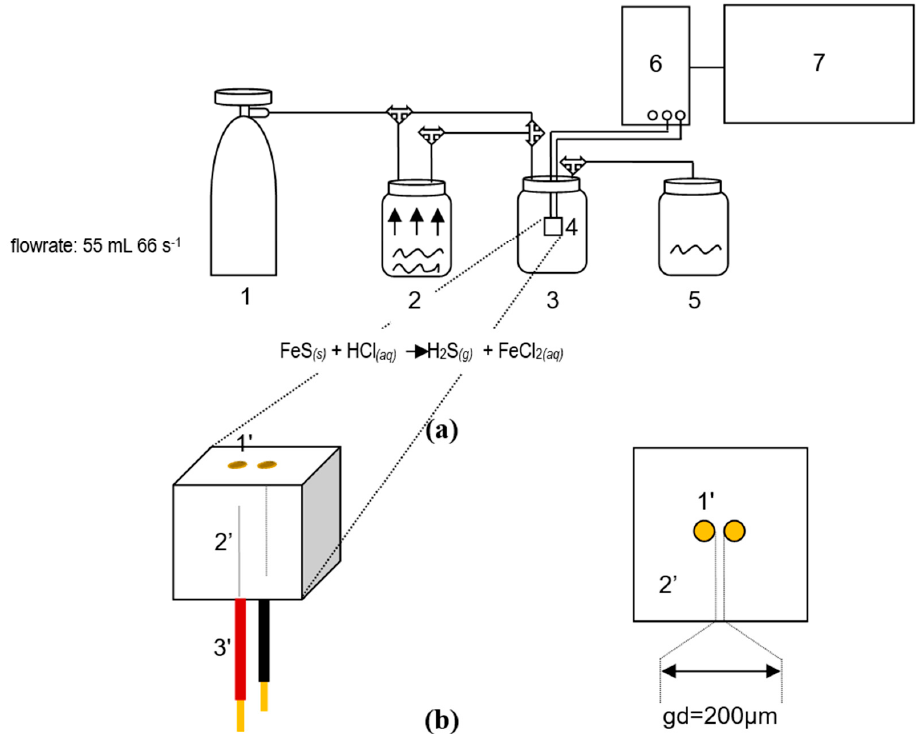
Figure 1. An illustration of the ( a ) gas sensing set-up: (1) N 2 tank, (2) reaction chamber, (3) sample chamber, (4) PI/AuNPs-based H 2 S gas chemiresistor sensor, (5) reservoir for exhausted gas,